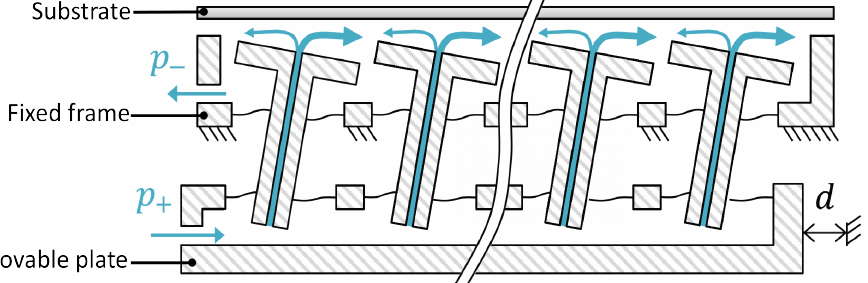
Figure 3. Schematic of the second generation contactless actuator, showing the flow of air through the system, for a displacement d of the movable plate